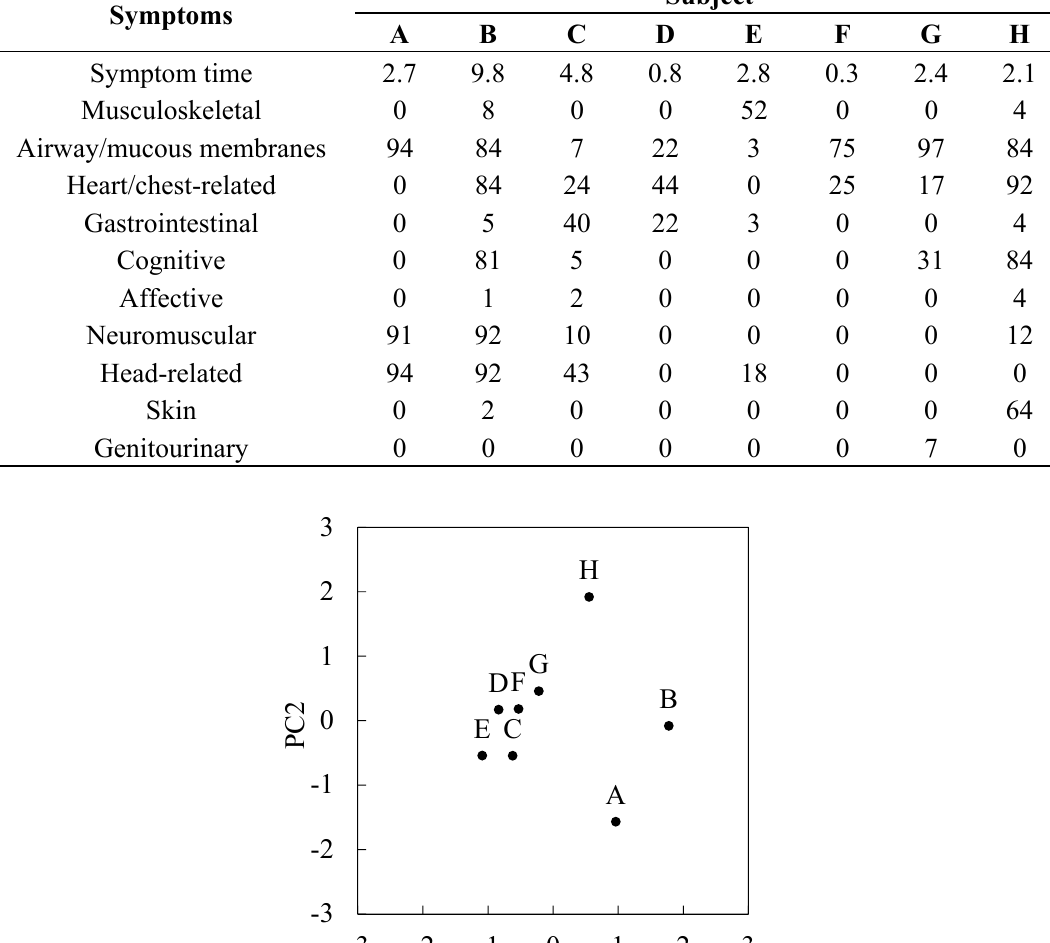
Table 3. Subjective symptom time (h) and time ratio of respective symptoms (%).